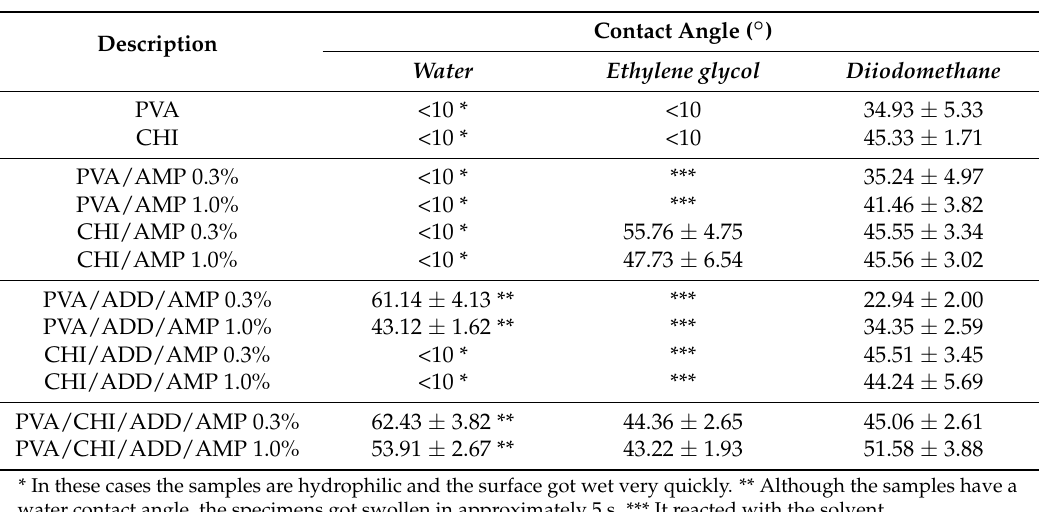
Table 1. Contact angle values for the prepared materials.